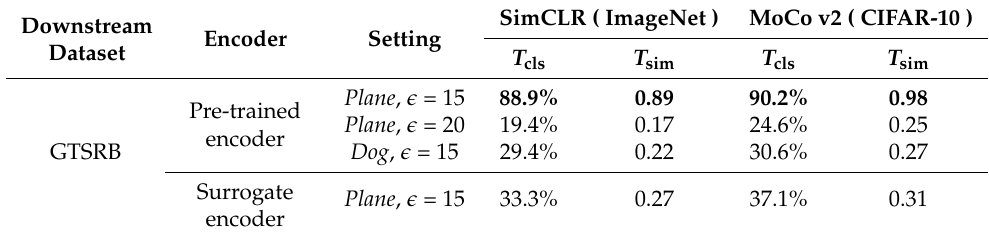
Table 4. Uniqueness evaluation due to different